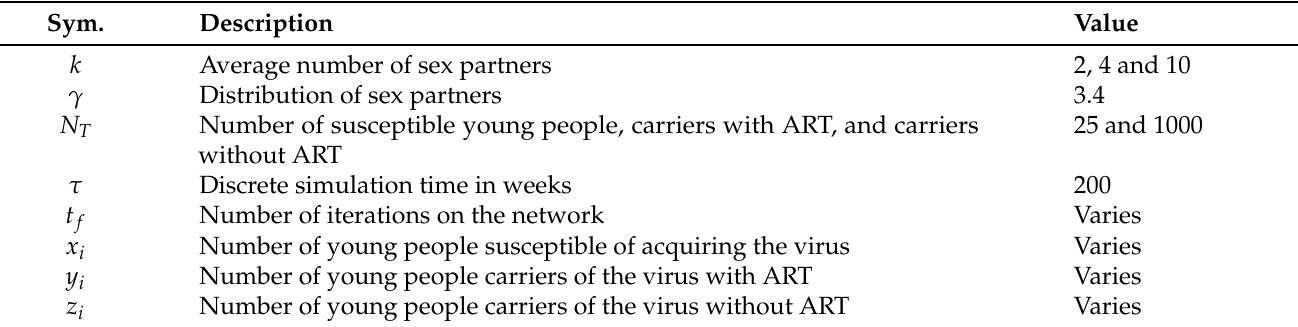
Table 1. Description of the parameters of the population model that will be used in the simulation. The intervals were assumed randomly and obtained from [17,27].